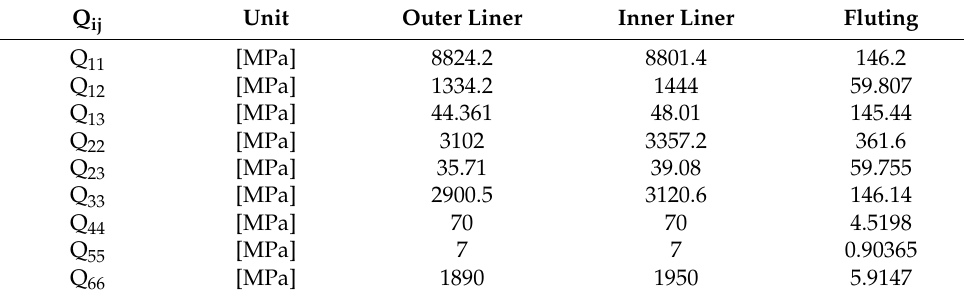
Table 3. Elements of the stiffness matrix for each layer, in Voigt notation.